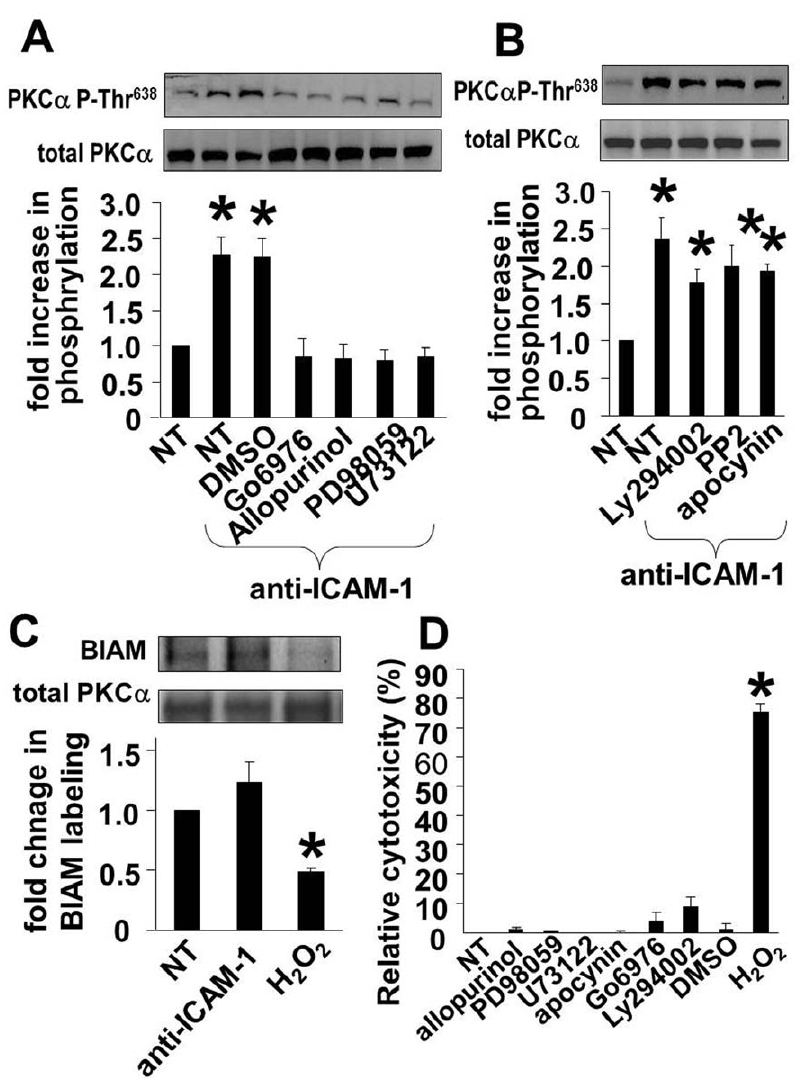
Figure 2. Anti-ICAM-1 stimulation induces an increase in PKC a Thr 638 phosphorylation through XO/PLC/ERK1/2 activities but not by oxidation. A,B,D ) 70% confluent monolayers of HMVECLs were pretreated with TNF a to induce ICAM-1 expression. Then, the endothelial cells were were treated for 1 hr with the pharmacological inhibitors allopurinol (0.3 mg/ml), PD98056 (20 m M), U73122 (10 m M), apocynin (4 mM), Ly294002 (100 nM), Go6976 (2.3 nM), PP2 (10 m M), apocynin (4 mM) or the solvent control DMSO (0.01%). The cells were stimulated with anti-ICAM-1-coated beads and examined for ( A,B ) PKC a Thr638 phosphorylation and total PKC a by western blot or examined for ( D ) cytotoxicity by the Vybrant cytotoxicity assay. In panel D, 200 m M H 2 O 2 was used as a positive control for cytotoxicity. C ) To label non-oxidized cysteines, BIAM was added to the cell lysates. PKC a was immunoprecipitated and BIAM labeling was detected by western blot with HRP-conjugated streptavidin. The blots were reprobed for total PKC a . The positive control for oxidation includes lysates oxidized with 200 m M H 2 O 2 for 20 min before addition of BIAM. Loss of BIAM labeling in the western blot indicates PKC a oxidation. Shown are the means 6 SEM from 3 experiments. *, p , 0.05 compared to nonstimulated (NS) controls. doi:10.1371/journal.pone.0041054.g002 to the cells as determined by the Vybrant Cell Metabolic Assay altering VCAM-1 expression [6]. We have also reported that these (Figure 4A). The tocopherols did not affect ICAM-1 expression by the HMVECL’s as determined by immunolabeling and flow cytometry (Figure 4B,C) . Treatment of HMVECLs with 60 m M a -tocopherol or2 m M c -tocopherol resulted in 10 m g a -tocopherol/ g cells and 2.8 m g c -tocopherol/g cells ( Table 1 ). This is consistent withreportsthathumanandmouselungtissuelevelsof a -tocopherol are 9–10 m g/g of tissue [45] and that c -tocopherol tissue levels are 5–10 fold lower than a -tocopherol [6]. In vivo, c -tocopherol tissue equivalent to the levels of tocopherol in lung tissue. Tocopherol levels are lower because of the preferential transfer in the liver by a - levels were determined by HPLC with ECD [6]. Treatment with tocopherol transfer protein [46]. In human plasma, the normal